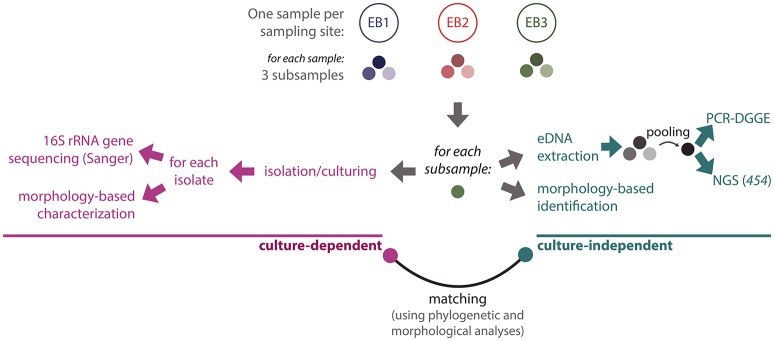
Schematic overview of the experimental design. See text for methodological details.